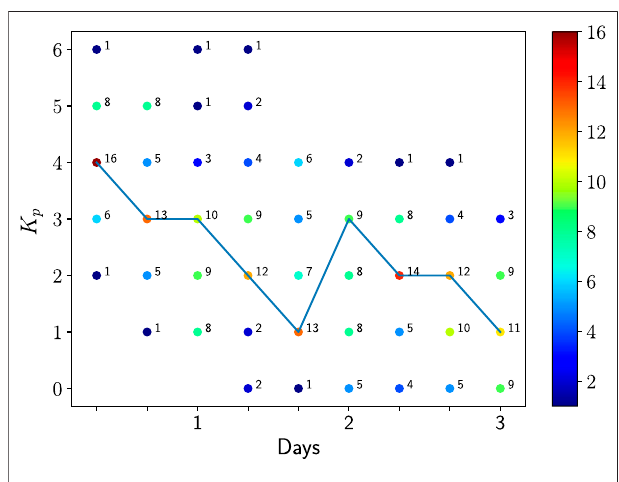
FIGURE7| Numbersofstormsthathave K p andtvalues.Thenumberof storms in each (t,Kp) bin is written and colored and represents the number of elements averaged together per